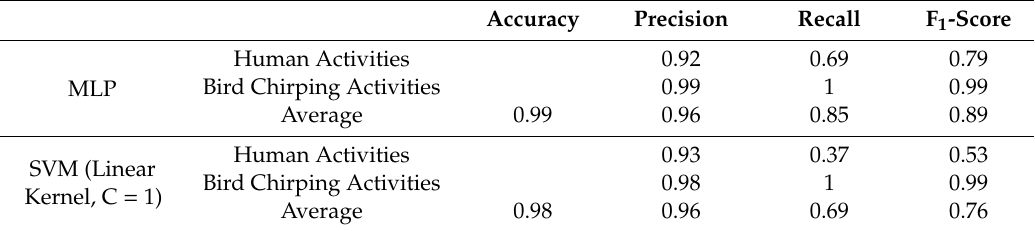
Table 3. Human activity and bird chirping activity classification results of the SVM and MLP models without the denoising technique applied.